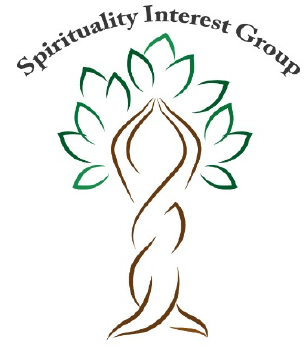
Figure 1. Spirituality Interest Group Logo © .